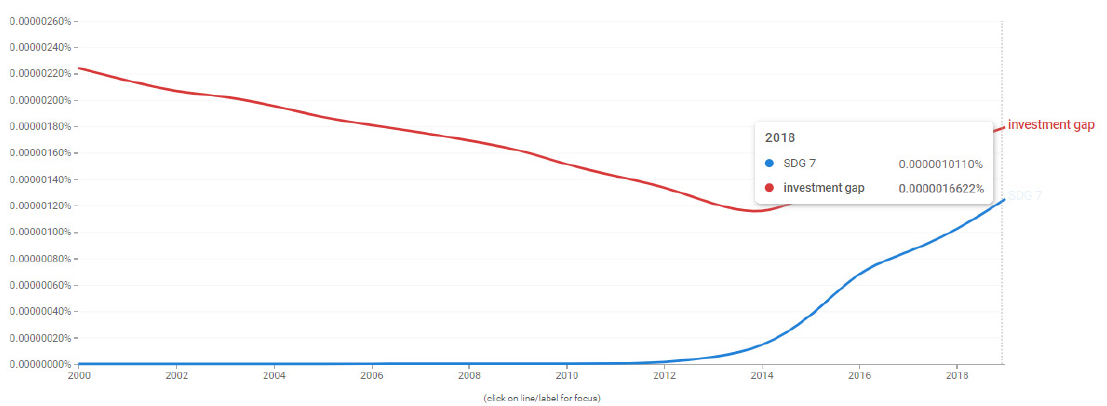
Figure 9. Ngram on the research terms of SDG 7 and Investment gap in